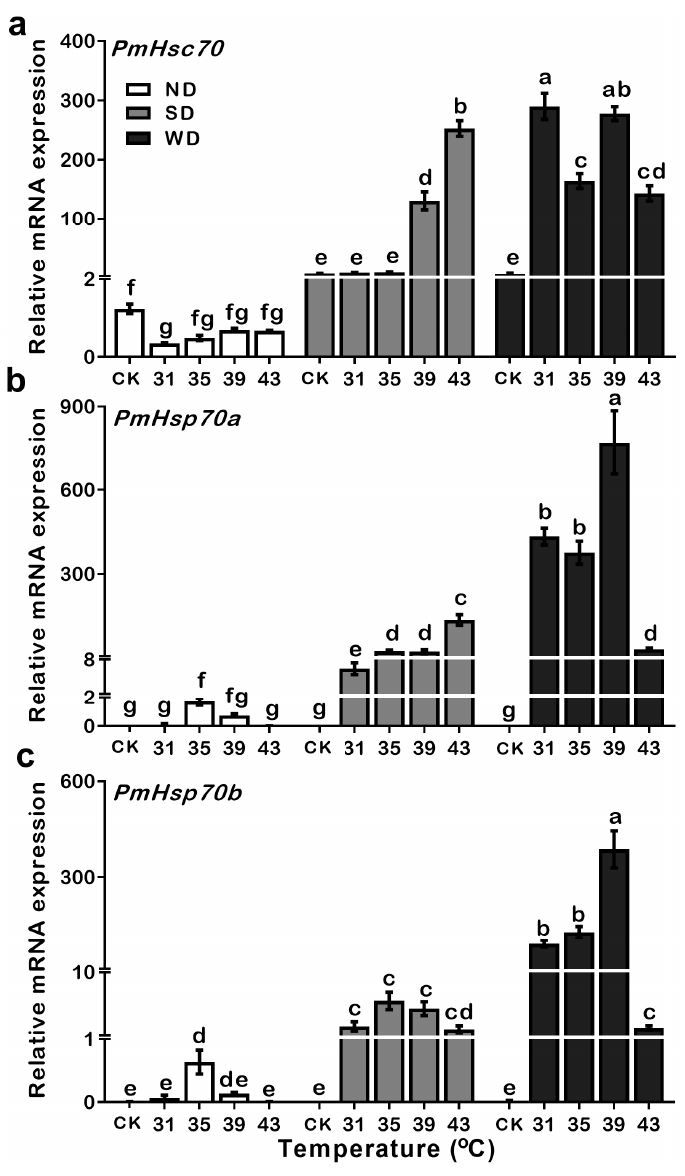
Figure 5. Relative mRNA expression levels of PmHsc70 ( a ), PmHsp70a ( b ), and PmHsp70b ( c ) in response to heat treatment in ND, SD, and WD pupae of Pieris melete . The relative expression levels (Mean ± SE) are normalized to β -actin and 18S rRNA. Different letters above the bar indicate significant differences by ANOVA and hoc Bonferroni multiple comparison test ( p <